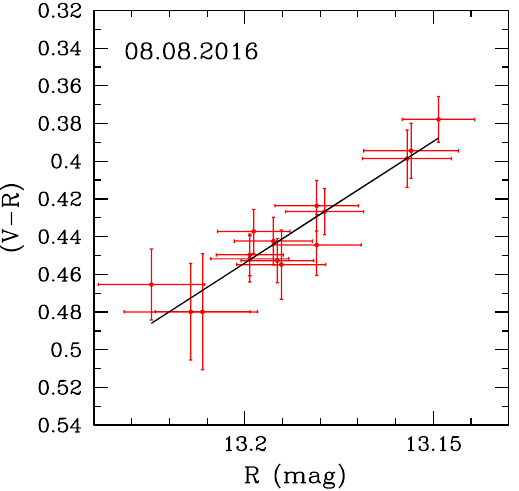
Figure 5. Sample color-magnitude diagram for BL Lacertae. Table 3. Results of linear fits to color index-flux